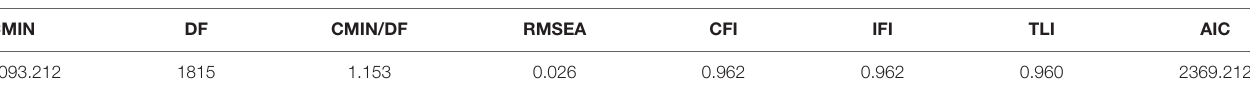
TABLE 3 | Result of full measurement model